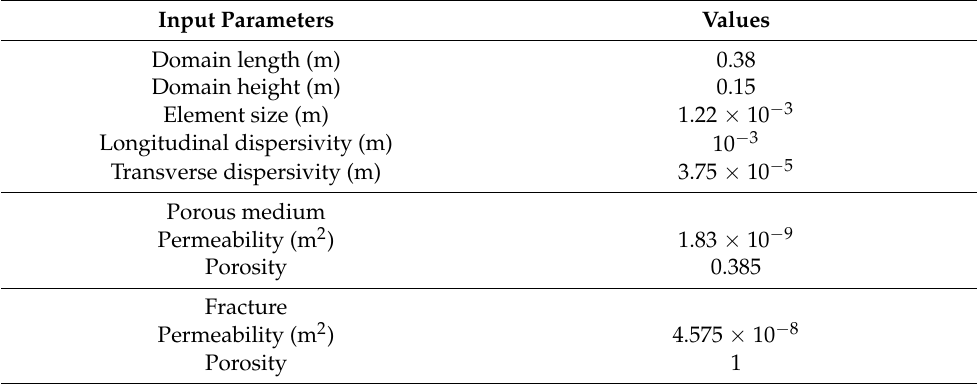
Table 1. Numerical model